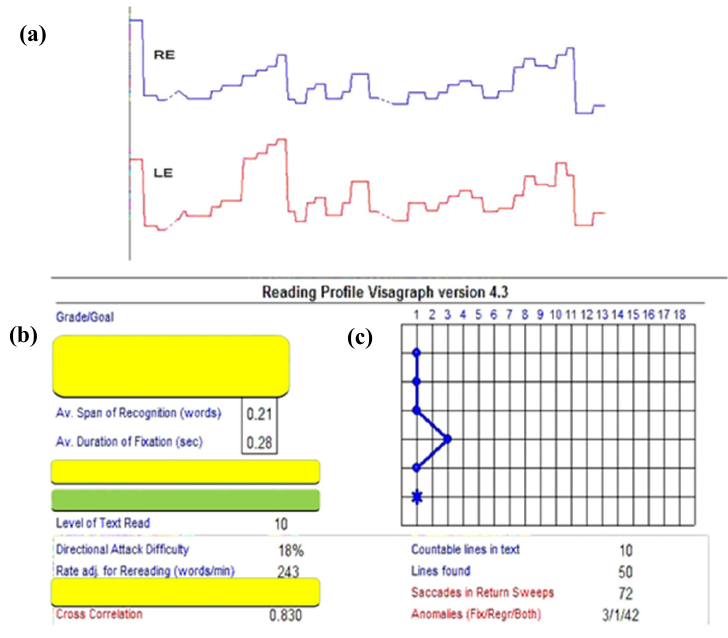
Figure 4. Visagraph output in a typical mTBI subject at baseline: ( a )—Horizontal eye position as a function of time (8 s data); RE = right eye; LE = left eye; Upward inflection = progressive saccade; downward inflection = regressive saccade. ( b , c )—On the left ( b ) = Various Visagraph parameters assessed for grade-10 reading material; Graph plot on the right ( c ) = Taylor’s [24] grade level efficiency (from 1–18; >12 is normal), showing a level of 1.0 (blue star) in this subject. Relevant parameters are highlighted [15].